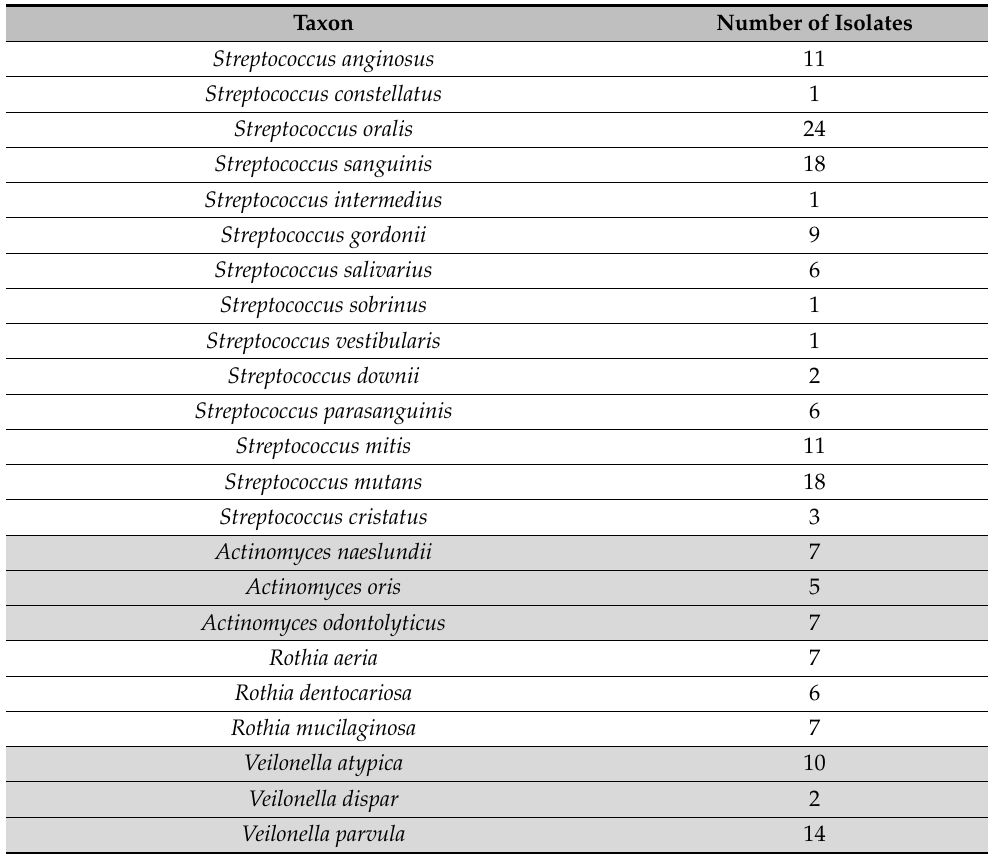
Table 1. Clinical oral isolates included in this study.